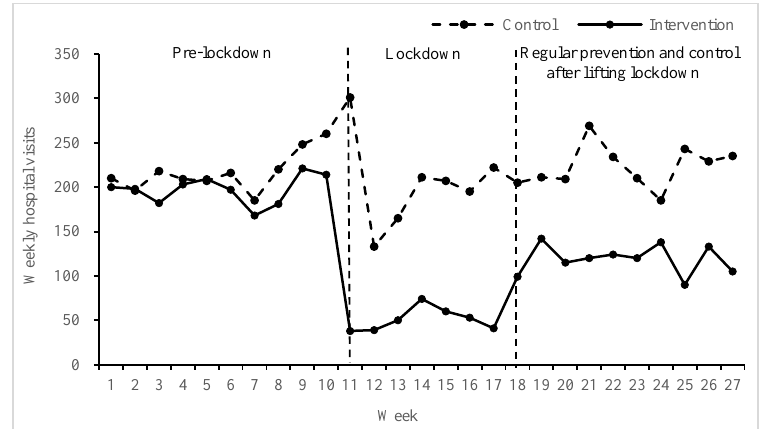
Figure 1. Weekly visits of asthma patients and distribution of epidemic prevention and control measures in Yichang.